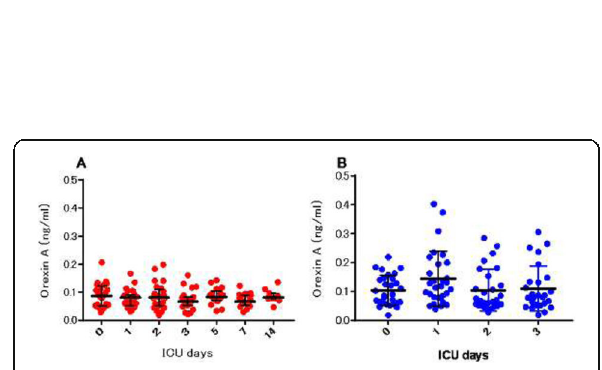
Fig. 3 (abstract 0120). Chronological changes in plasma concentrations of orexin A in Septic patients and in non-septic surgical patients. A: Septic group, B: Non-septic surgical